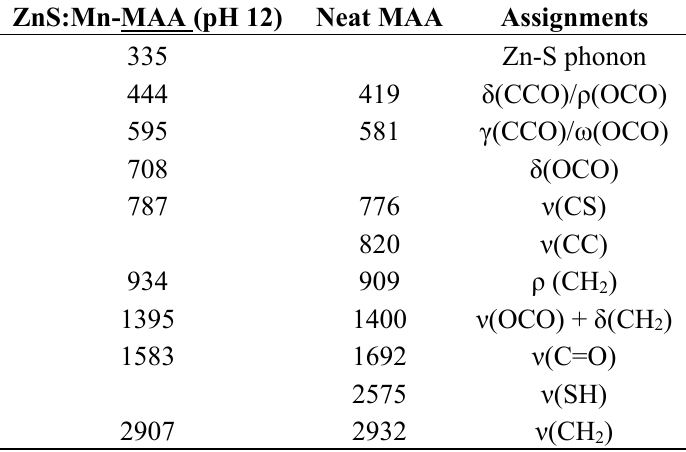
Table 1. FT-Raman data and assignments of ZnS:Mn-MAA (mercaptoacetic acid) NC (nanocrystals) prepared at pH 12 (unit in cm − 1